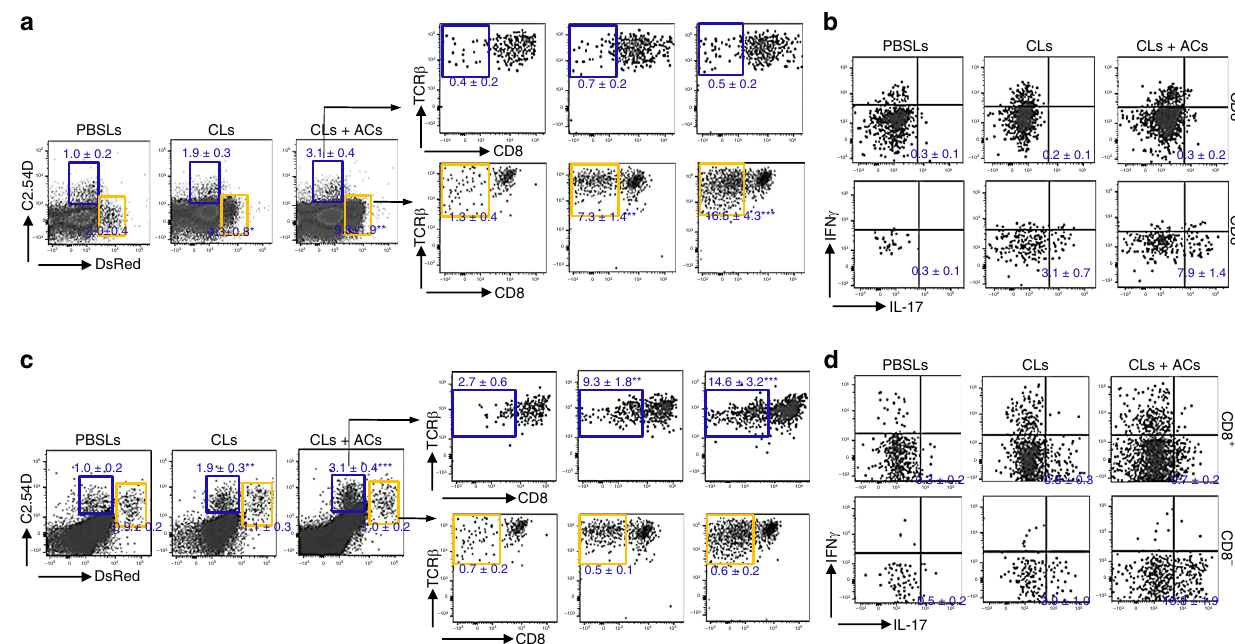
Fig. 3 Autoreactive Polyclonal CD8 T cells differentiate into DN T cells. A mixed population of puri fi ed CD8 T cells (TCR β + NK1.1 − CD8 + , 2 × 10 6 /mouse, 1:1 ratio) from Cd45.1 B6 mice and Cd45.2 B6. lpr.DsRed ( a , b ) or from normal Cd45.2 B6. DsRed mice and Cd45.2 B6 Aire − / − mice ( c , d ) were transferred into either Cd45.2 B6 ( a , b ) or Cd45.1 B6 ( c , d ) recipients. Twelve hours later, recipients were administered with control liposome, CLs, CLs plus apoptotic thymocytes prepared from B6 mice. Mice were euthanized after an additional 72 h. n = 5 mice per group for two independent experiments. a Left: fl ow cytometry analysis of the percentage of the transferred CD8 T cells in the spleens of Cd45.2 B6 recipients with the indicated treatment. Right: fl ow cytometry analysis of CD8 expression on the surface of the transferred CD8 T cells in the spleens of Cd45.2 B6 recipients with indicated treatment. b Flow cytometry quantitation of the percentage of IL-17 + and IFN- γ + cells in CD8 − (upper) and CD8 + (lower) populations derived from transferred CD8 T cells. c Left: fl ow cytometry analysis of the percentage of the transferred CD8 T cells in the spleens of Cd45.1 B6 recipients with indicated treatment. Right: fl ow cytometry analysis of CD8 expression on the surface of the transferred CD8 T cells in the spleens of Cd45.1 B6 recipients with indicated treatment. d Flow cytometry quantitation of the percentage of IL-17 + and IFN- γ + cells in CD8 − (upper) and CD8 + (lower) populations derived from transferred CD8 T cells. Data represent the mean ± SEM (* P < 0.05, ** P < 0.01, *** P < 0.005 vs. PBSLs-treated control, two-tailed Student ’ s t